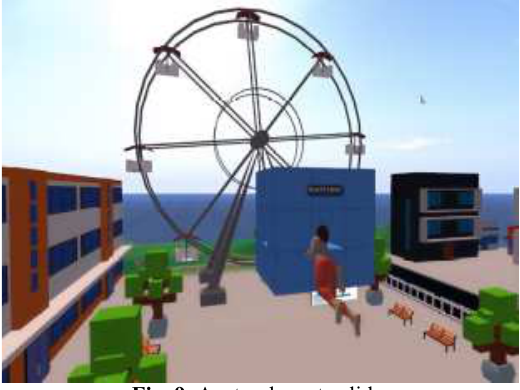
Fig. 9. Avatar devant